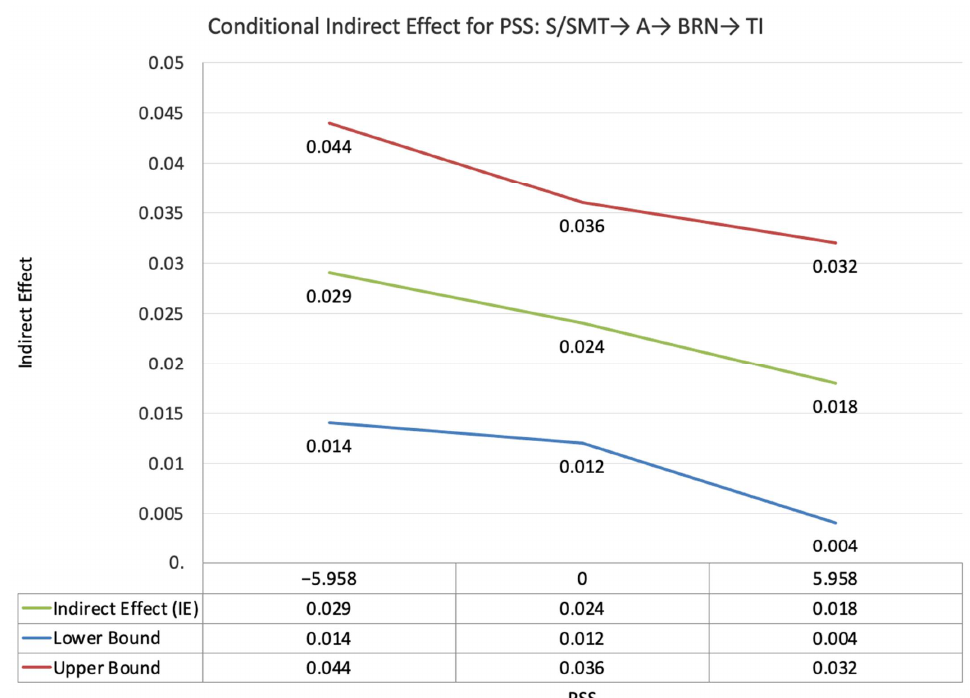
Figure 5. Conditional indirect effects of the difference between other-PMIEs compared to the control group on turnover intentions at low, average and high levels of self-disclosure, through relatedness satisfaction and work engagement.